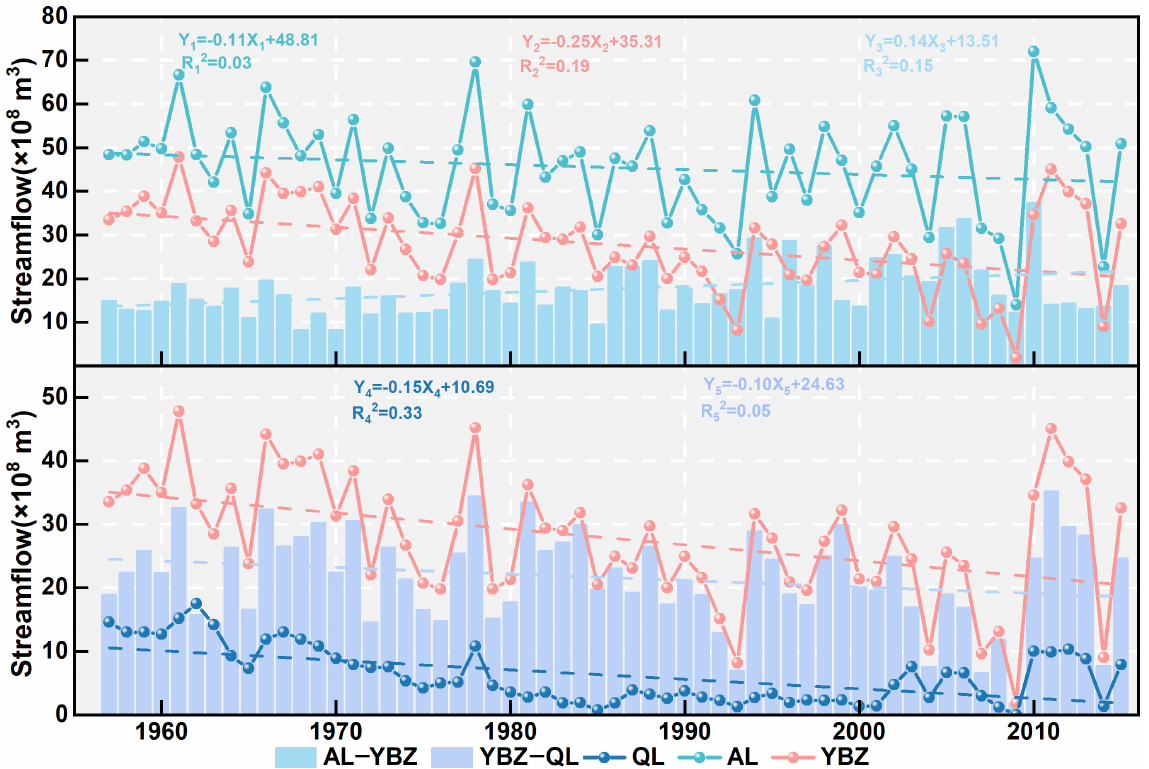
Figure 2. Surface water diversion from the upper reaches to the lower reaches of the Tarim River from 1957–2015. Table 1. Significance of climatic and hydrological variables for the period 1957–2015 (MK: Z value is the standard normal variate for the Mann–Kendall test; LM: β value is the slope of the regression line; Sig. is the p -value for the linear model test.